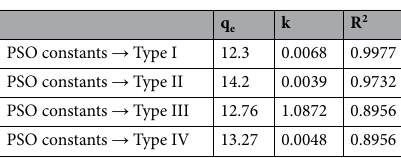
Table 3. Linear form of PSO models.